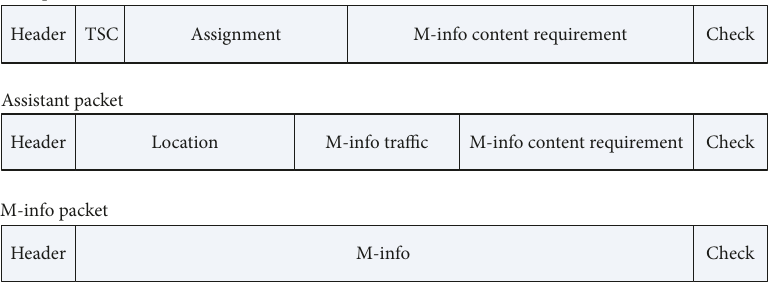
Figure 5: The structure of di ff erent packet